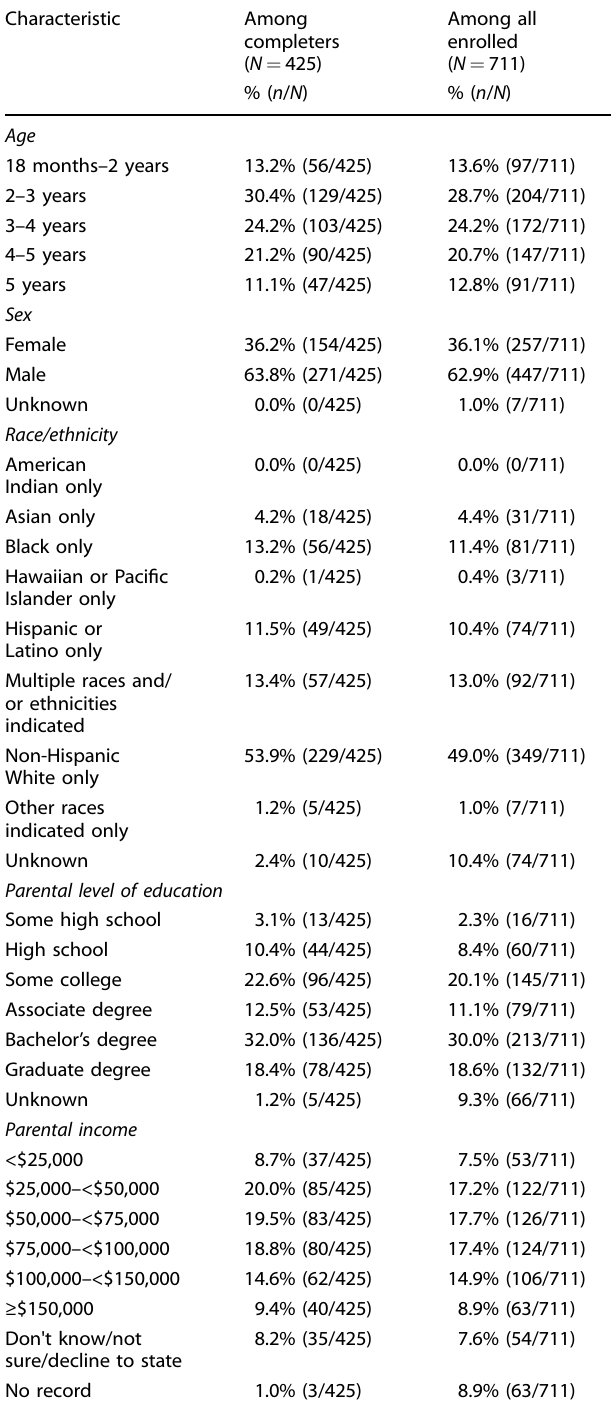
Table 1. Baseline characteristics and demographics.